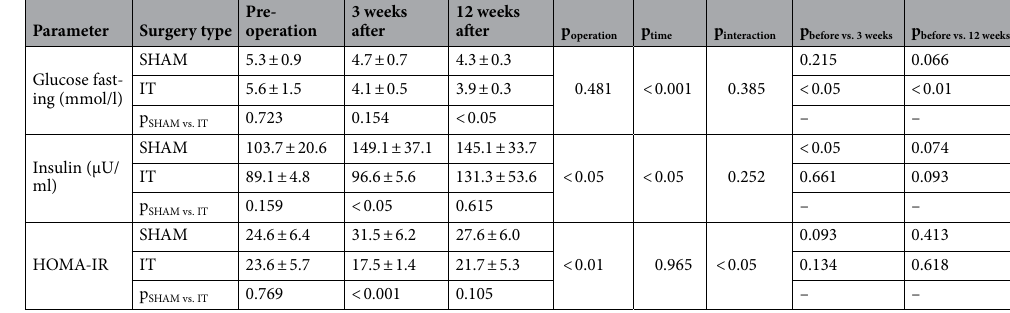
Table 4. Fasting glucose (mmol/l) and insulin (µU/ml) concentrations mesured in blood, and HOMA-IR of Zucker (Crl:ZUC(ORL)-Lepr fa ) rats before, 3 weeks and 12 weeks after control (SHAM) or ileal transposition (IT) surgery. The results are presented as mean ± standard deviation. Significance for p-value was set at < 0.05.